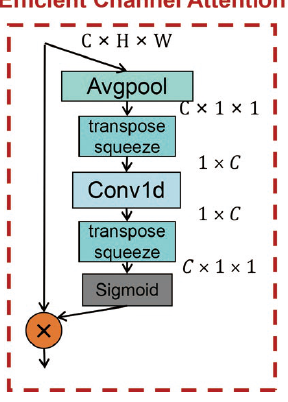
Figure 4. Structure of ECA module. Table 1. Comparison of the performances of the SE and ECA modules. Reduction ratios are set to 16 and 3 for SE and ECA, receptively. CSPA n represents the n -th CSPA